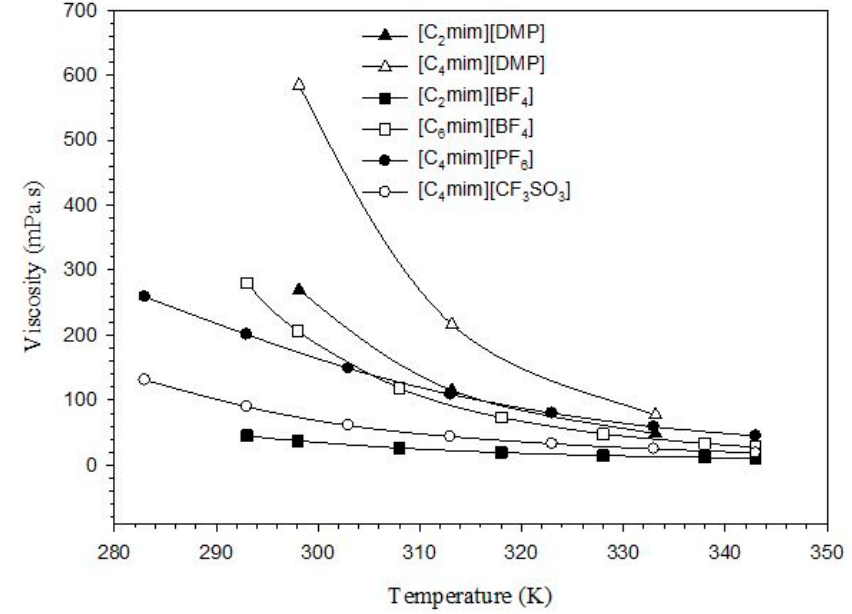
Figure 3. Effect of temperature on the viscosity of ILs [55–57]. Usually, reduction in viscosity and increase in specific heat capacity of ILs are com- monly used by mixing with water. For binary mixture of IL and water, the heat capacity